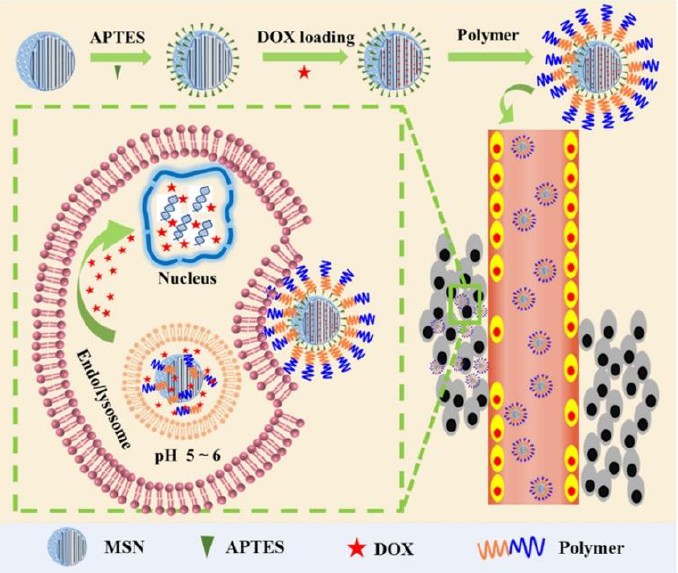
Figure 16. Schematic illustration of the preparation of Polymer@MSN-DOX and pH-triggered release of DOX. Reprinted with permission from [210]. Copyright 2019 Elsevier.